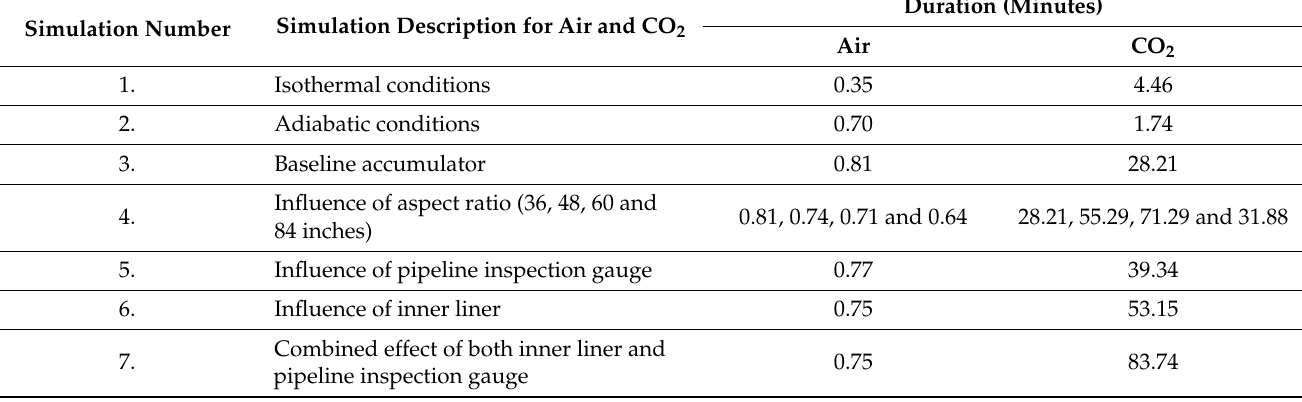
Table 2. Duration of the different simulations considered for this